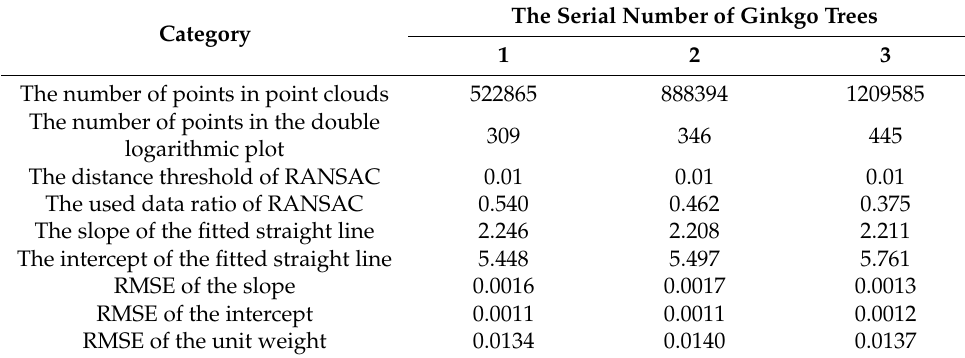
Table 2. Calculation results of box-counting dimensions of point clouds by using the method based on which was RANSAC gross error elimination